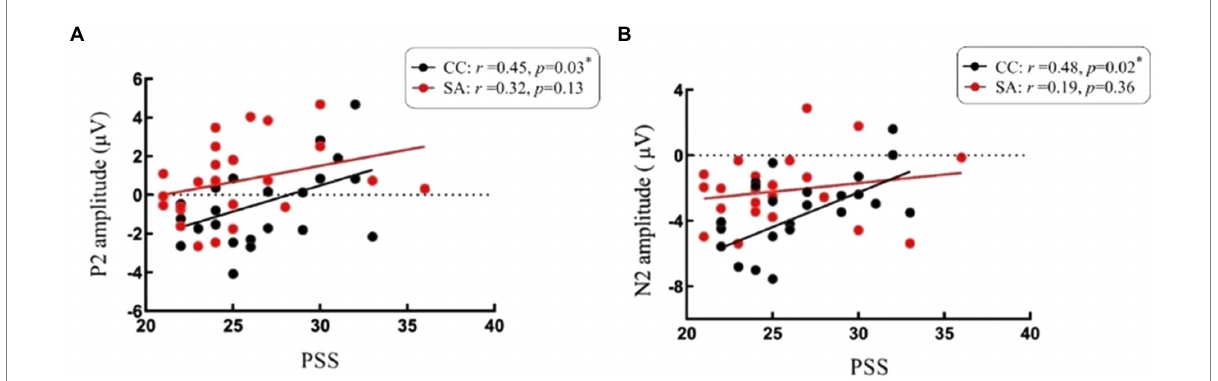
FIGURE 5 Scatterplots depicting correlations between self-perceived stress level and ERP responses. (A) Correlations between P2 and scores of Perceived Stress Scale (PSS). (B) Correlations between N2 and scores of Perceived Stress Scale (PSS). * p < 0.05. Red spot and line represent participants of self-awareness group (SA). Black spot and line represent participants of control group (CC).